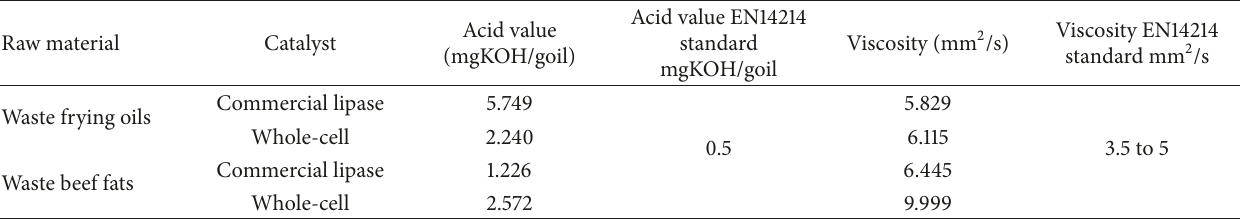
Table 2: Determination of acid value, water content, and viscosity of biodiesel issued from WFO and WBF transesterification through the biological